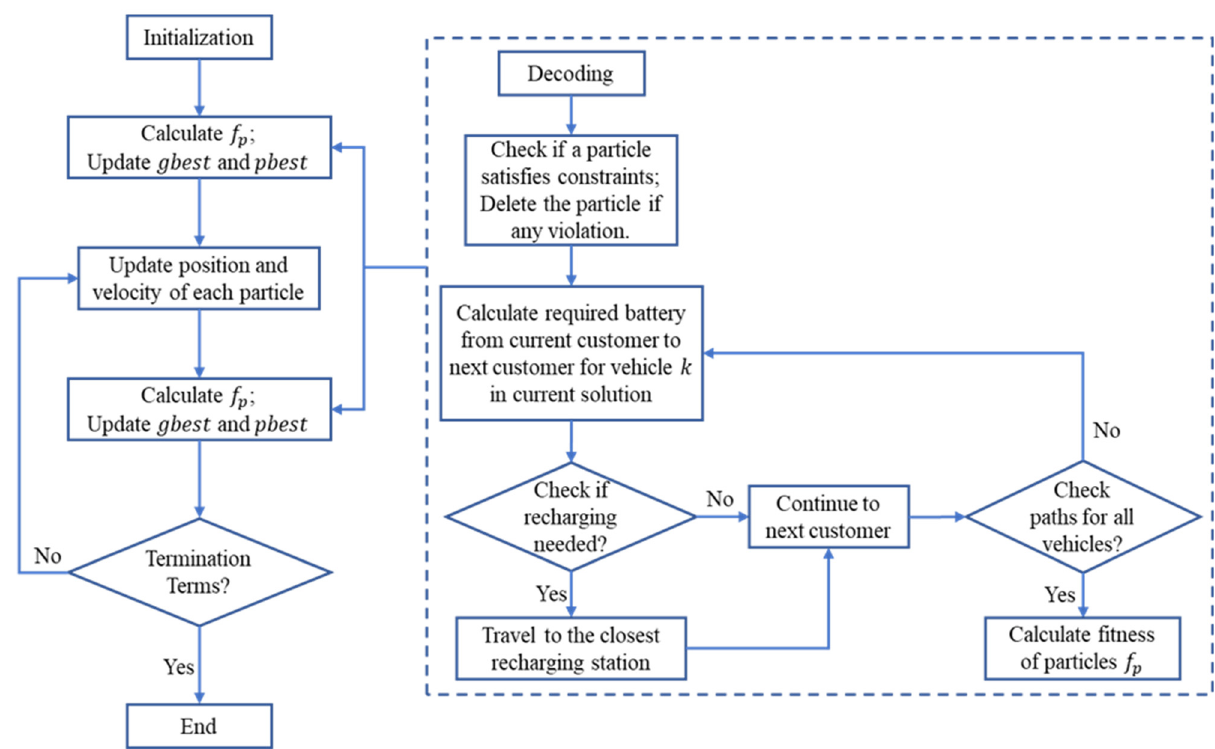
Figure 5. Flowchart of adaptive PSO algorithm.